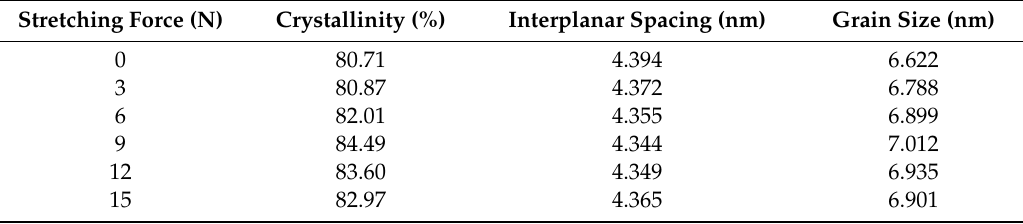
Table 5. Crystallinity characteristics of the fibers treated under tension in pure scCO 2 .